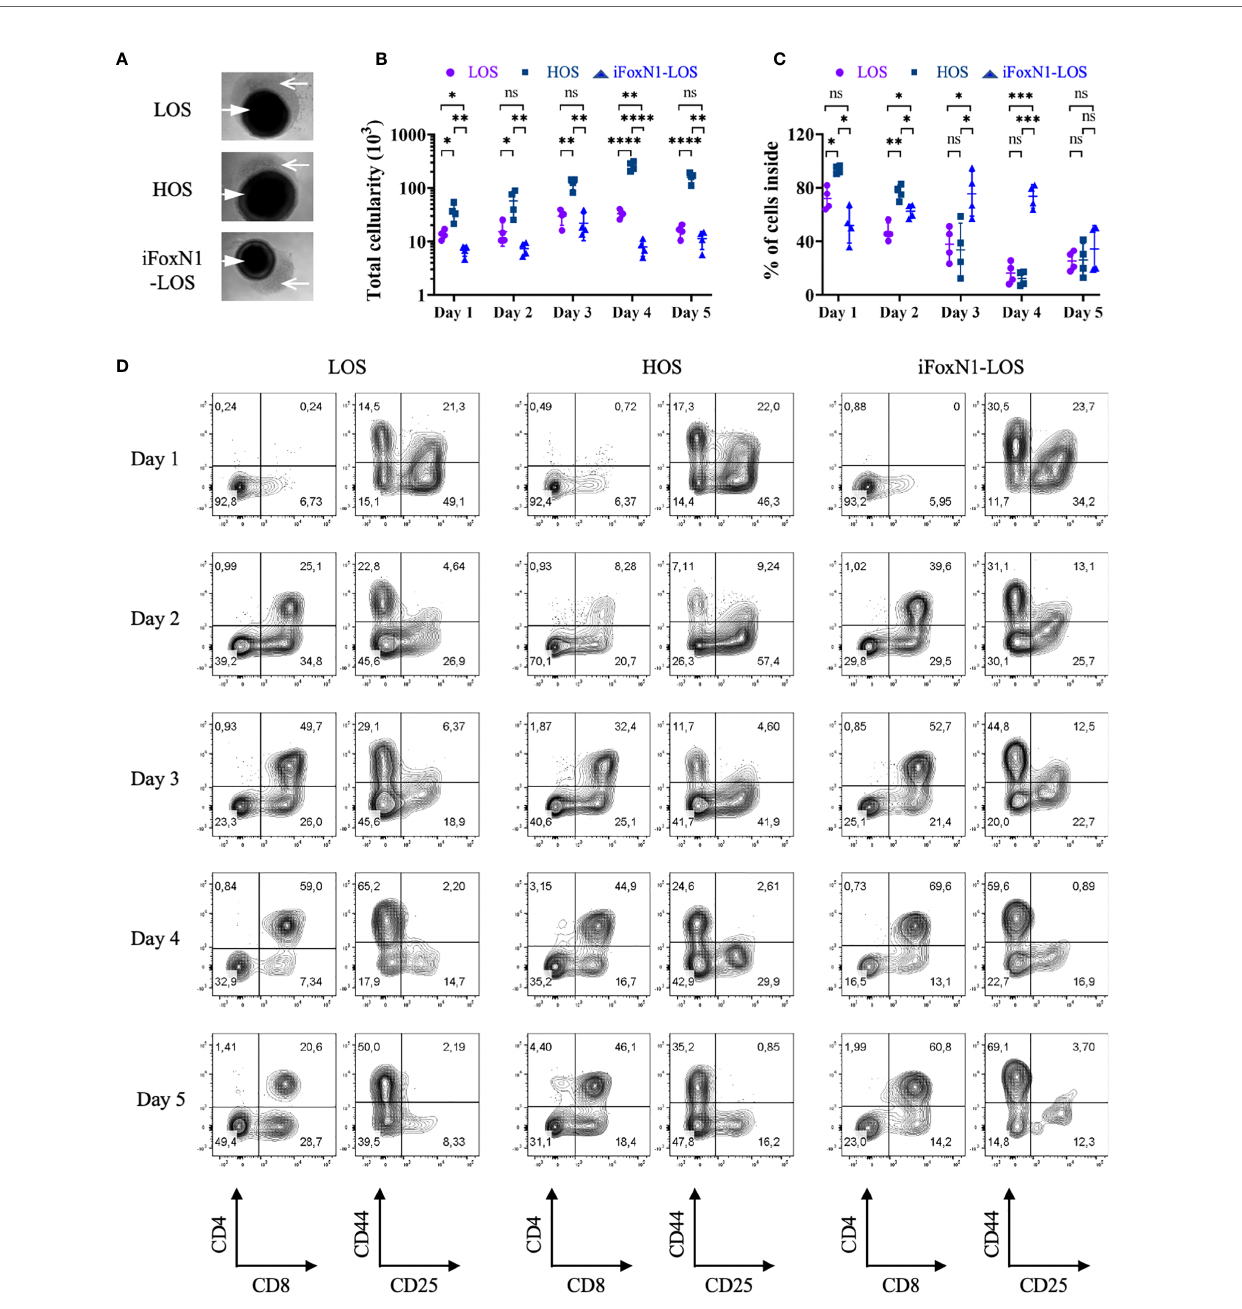
FIGURE 3 | Temporal analysis of T cells development from LOS, HOS, and iFoxN1-LOS cultures. (A) Phase-contrast images of submersion cultures on day 2 of culture are shown, with closed arrow pointing to thymus lobes and open arrow indicating cells outside of lobes. (B) Scatter dot plots and statistical analysis (two-way ANOVA with post-hoc Tukey ’ s test) of total cell numbers, including cells both inside and outside of lobes, of individual culture conditions on each day within the fi rst 5 days of culture. (C) Scatter dot plots and statistical analysis (two-way ANOVA with post-hoc Tukey ’ s test) of the percentage (%) of cells inside of lobes, as indicated. (D) Flow cytometric analysis of thymocytes inside of lobes from LOS, HOS, and iFoxN1-LOS cultures, as indicated. For each culture condition, the left contour plots show CD4 and CD8 expression of CD45 + gd TCR − gated cells and the right panels display CD44 and CD25 expression of CD45 + gd TCR − CD4 − CD8 − gated cells. ns, not signi fi cant; p > 0.05; *p < 0.05; **p < 0.01; ***p < 0.001; ****p <